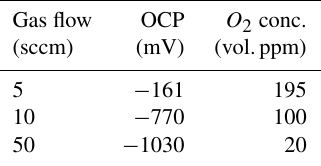
Table 2. Oxygen concentrations in measuring gases during the voltammetric measurements shown in Fig.